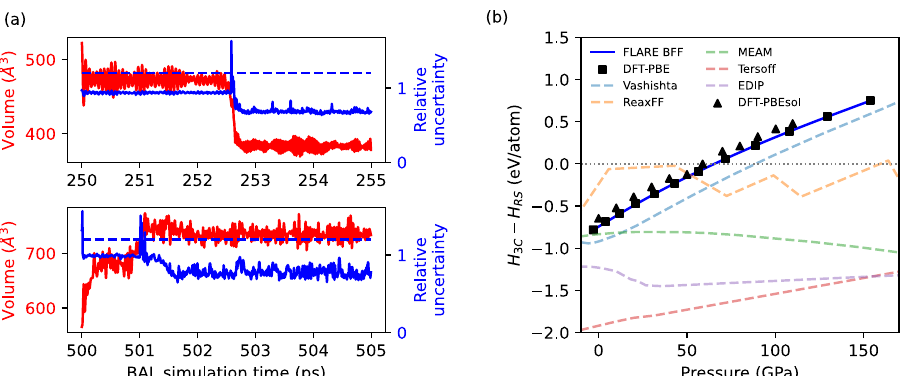
Fig. 2 Phase transition simulation with FLARE BFF and enthalpy calculations. a A 5 ps segment of the whole training trajectory where the 3C-RS phase transition is captured during the compressive (decompressive) on-the- fl y active learning, the volume decreases (increases), and the model uncertainty spikes in the transition state. The uncertainty threshold is shown as the blue dashed line. DFT is called, and new training data is added to the model when the relative uncertainty exceeds the threshold. b Enthalpy difference predictions from DFT (PBE, PBEsol 34 ), FLARE BFF and existing empirical potentials 40,42,44,54,56 at pressures from 0 to 150 GPa. The crossing with the dotted zero line gives the transition pressure predicted by